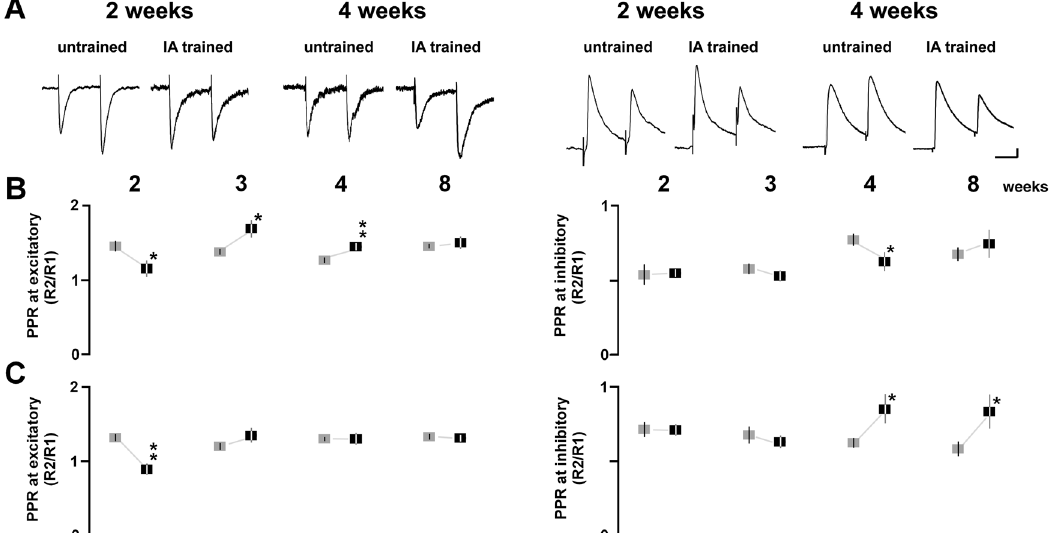
Figure 4. Postnatal development of IA-task-induced presynaptic plasticity. ( A ) Representative traces of AMPA (left) and GABA A (right) receptor-mediated paired-pulse responses stimulated apical dendrites of CA1 neurons. ( B ) Postnatal development of the ratios by apical dendrite stimulation in untrained (gray) and trained (black) rats. ( C ) Postnatal development of the ratios by basal dendrite stimulation in untrained and trained rats. The numbers under the graphs indicate the number of neurons. The error bars indicate ± SEM. * P < 0.05, ** P < 0.01 vs.